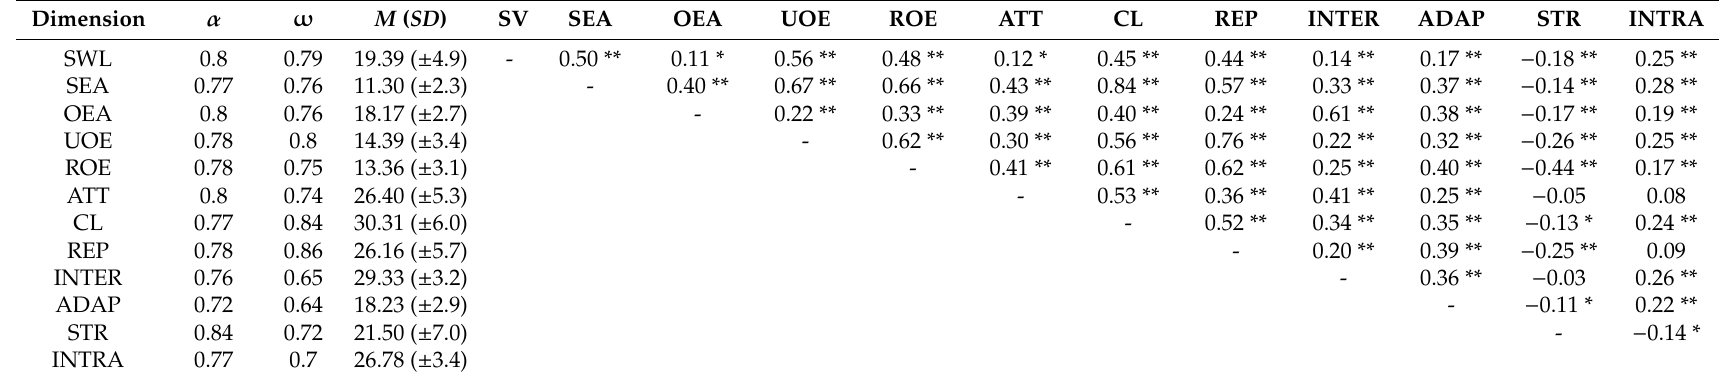
Table 1. Internal consistency, mean, standard deviation and Spearman’s Rho correlation of the variables life satisfaction and emotional intelligence.